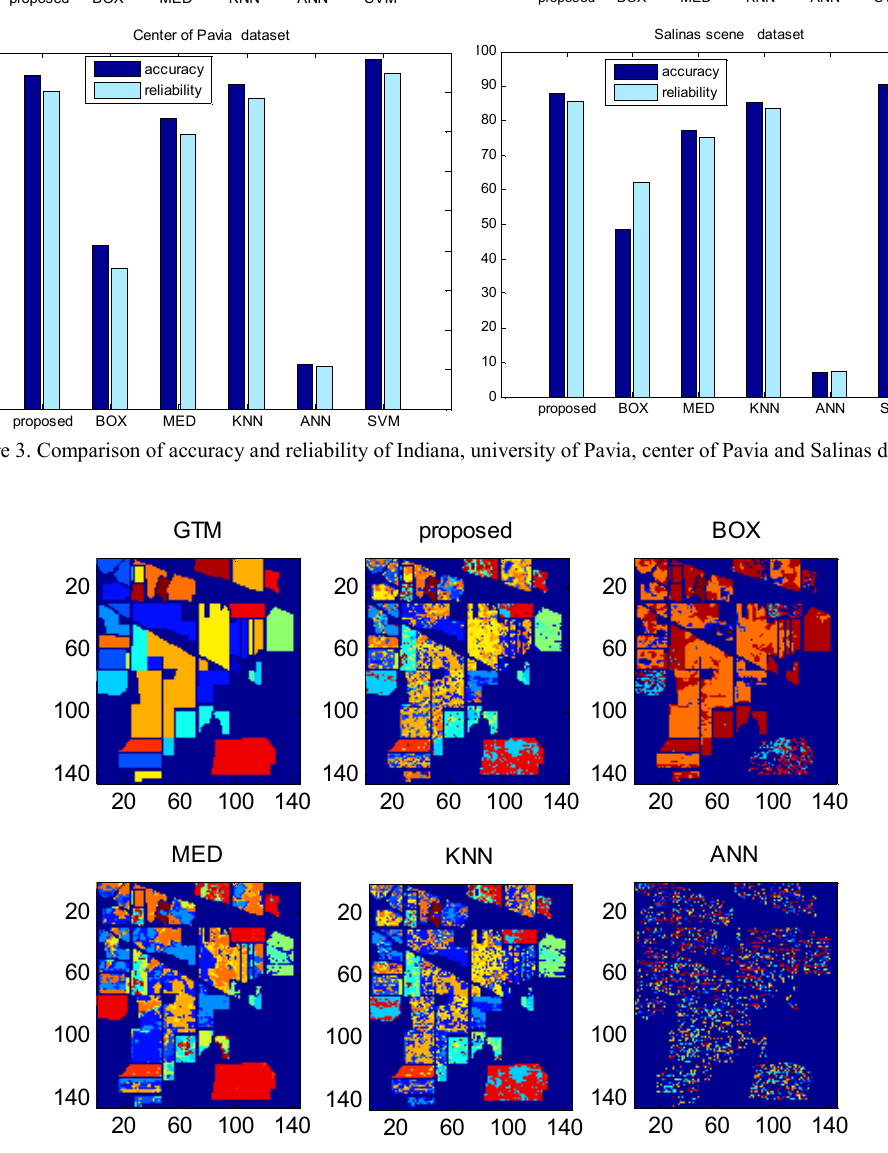
Figure 4. Ground Truth Map (GTM) and classification maps for Indiana